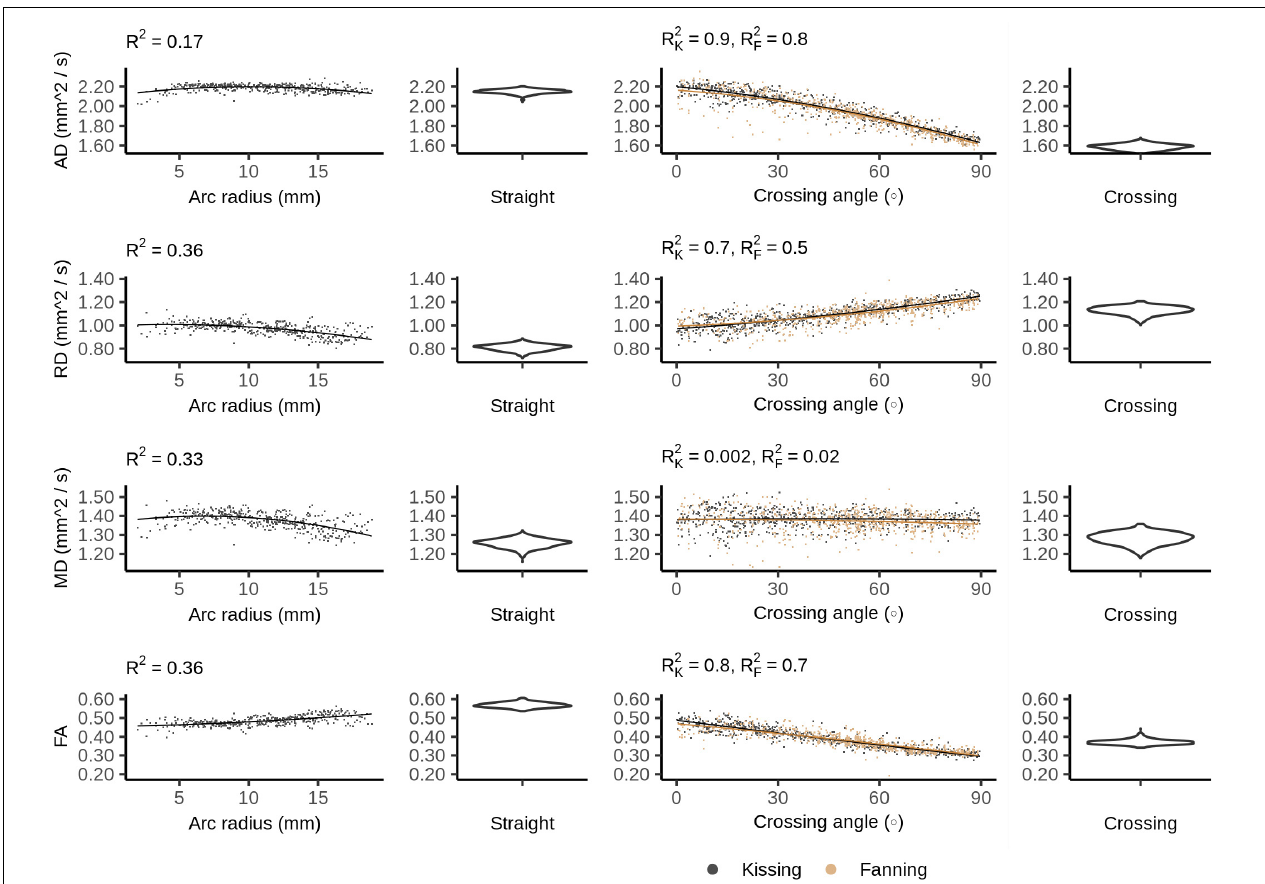
FIGURE 4 | Diffusion tensor imaging (DTI) metrics vs. orientation dispersion metrics in each of the four phantoms. Each sample corresponds to a single voxel. Each row depicts the relationship between one metric and orientation dispersion, and each column depicts the data from one or two phantoms. From left to right, those phantoms are: bending, straight, fanning and kissing, and crossing. The violin plots shown for the straight and crossing phantoms depict the probability density of values observed in the voxels of those phantoms. R 2 K refers to the R 2 of the data from the kissing phantom and R 2 F refers to the R 2 of the fanning phantom.